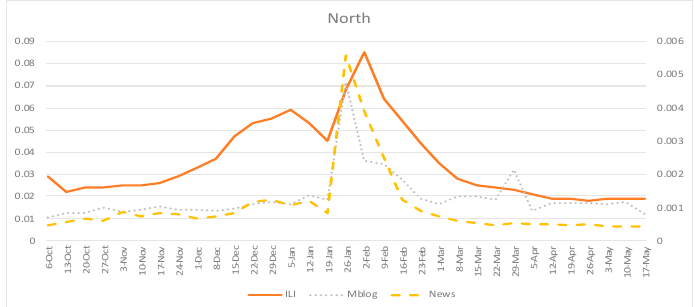
Figure 2. Weekly time series of CNIC’s ILI rates, fraction of influenza-related online news articles, and fraction of influenza-related microblogs: north of mainland China, 6 October 2019–17 May 2020. ILI = influenza-like illness rates from CNIC; Mblog = fraction of influenza-related microblogs; News = fraction of influenza-related online news articles. In Tables 1 and 2, the optimal lags for different data sources, leading to the lowest RMSE for each model, are shown in the parentheses. Boldface highlights the best perfor- mance for each index in south and north mainland China. The paired t -test results, com- paring our proposed model with baseline models, are shown in the last column. The t value is present in the last column with the related p -value in the parentheses below it. *** means significant at 1% level, ** means significant at 5% level, and * means significant at 10% level. Table 1. Comparison of different models for the forecasting of influenza epidemics: south of main- land China. Model (lag)